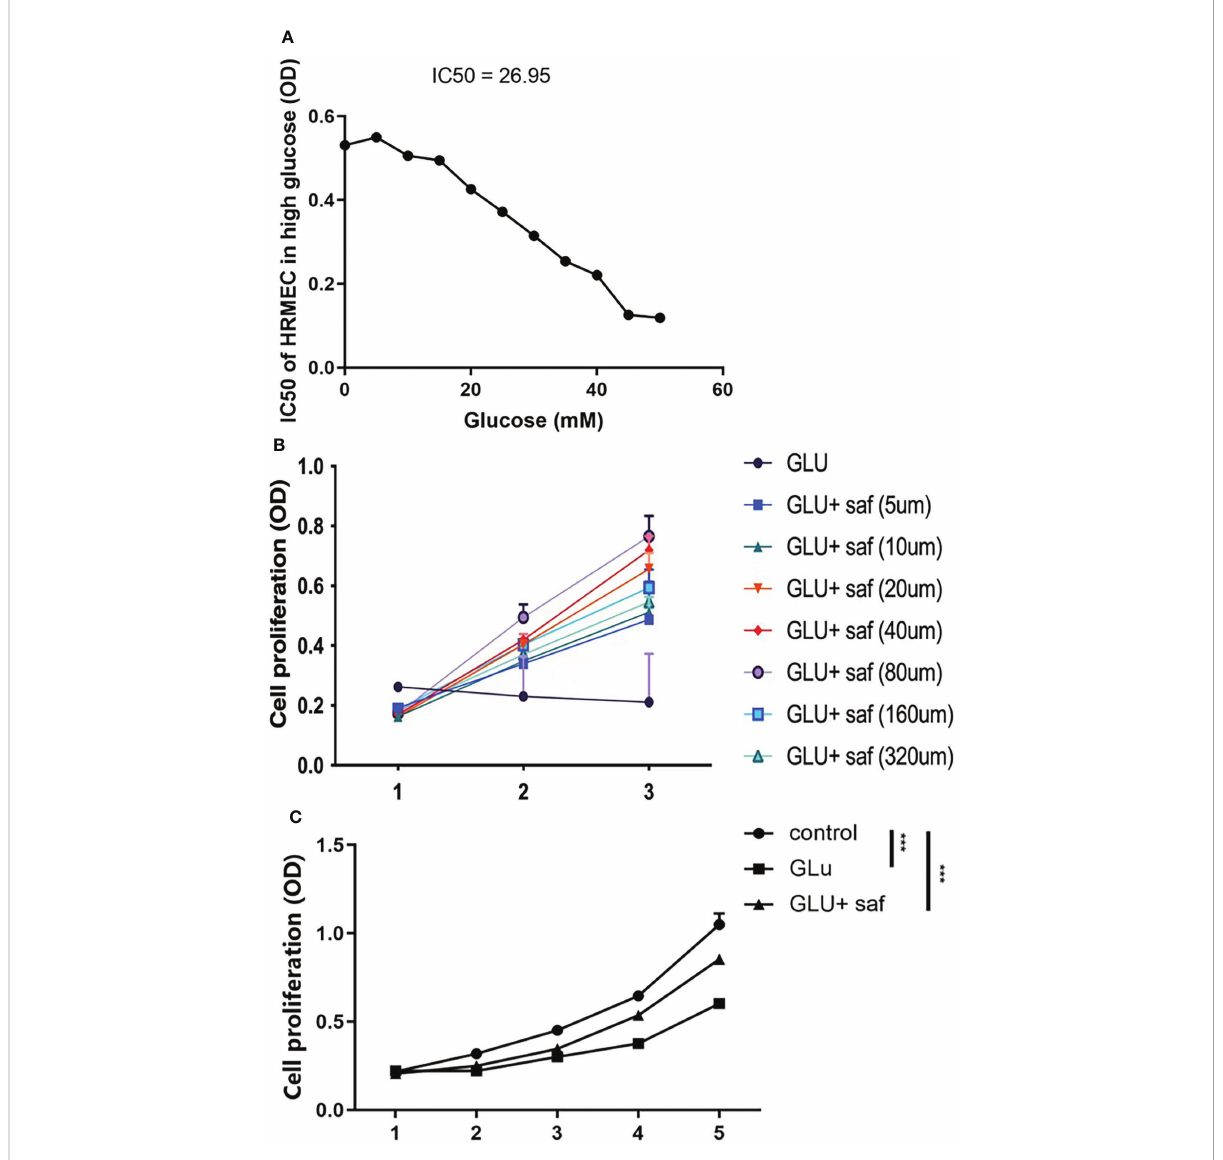
FIGURE 1 Safranal ’ s protective effect on cell proliferation in HRMECs in high glucose damage conditions. (A) shows that under different concentrations of glucose, cell proliferation was inhibited with an IC50 of 26.95. Cell proliferation was protected under different concentration of safranal while 80 m M demonstrated the best protection effect (B) . After fi ve days of incubation, safranal had a better protective effect on cell proliferation over time P<0.001; (C)